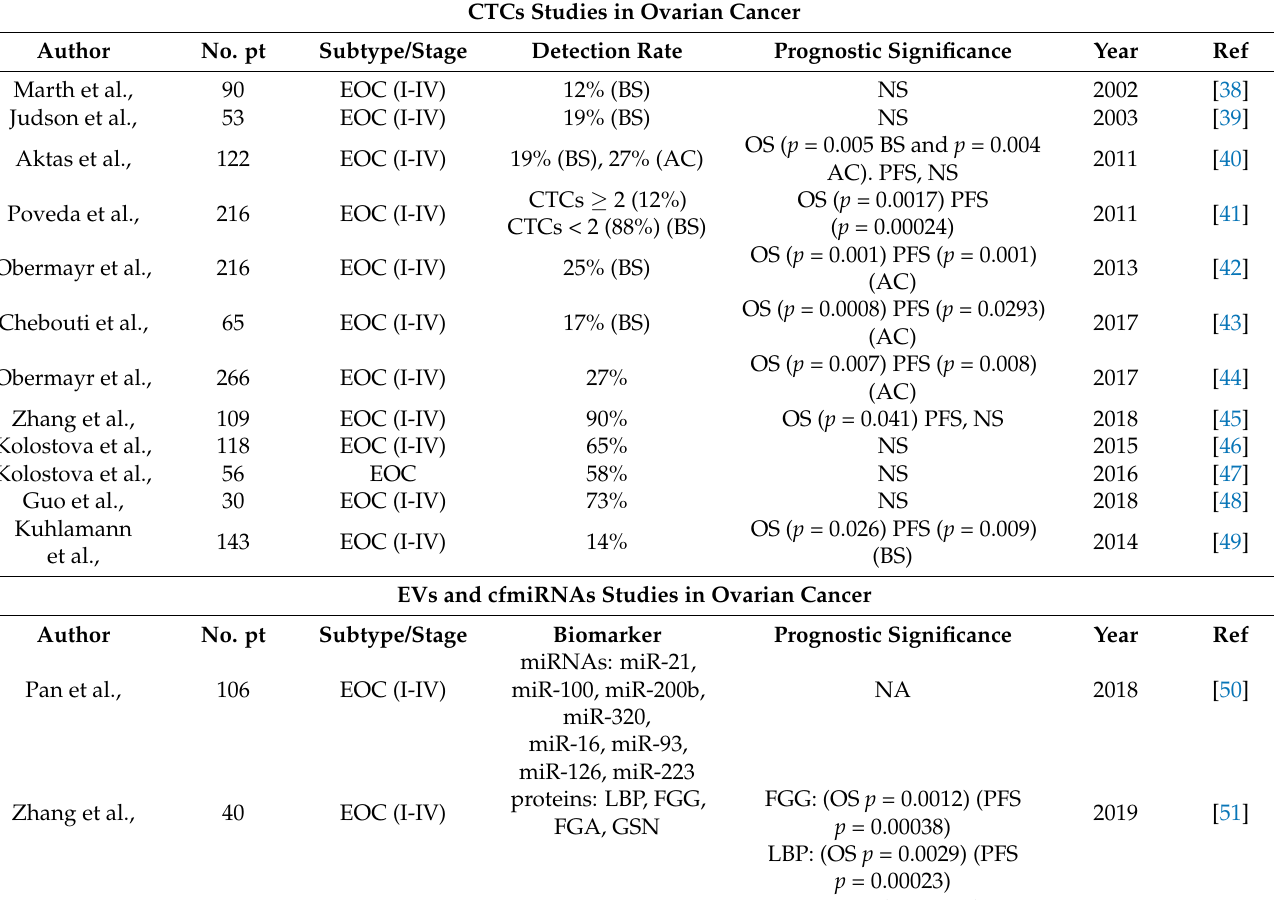
Table 1. Applications of liquid biopsy in ovarian cancer studies. No. pt, number of patients; EOC, epithelial ovarian cancer; OS, overall survival; PFS, progression-free survival; NS, not significant; NA, not available; AC, after chemotherapy; BS, before surgery; CNA, copy number